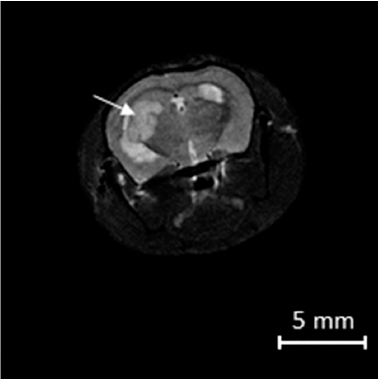
Figure 1. Axial MRI sections of the mice brains 4 weeks after xenotransplantation of U87MG cells. Arrow points to the tumor.